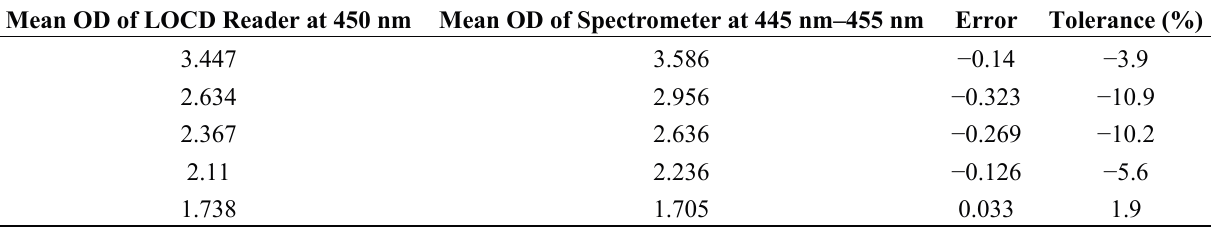
Table 1. Comparison of absorbance results from LOCD ELISA detection platform with absorbance values from spectrophotometer.